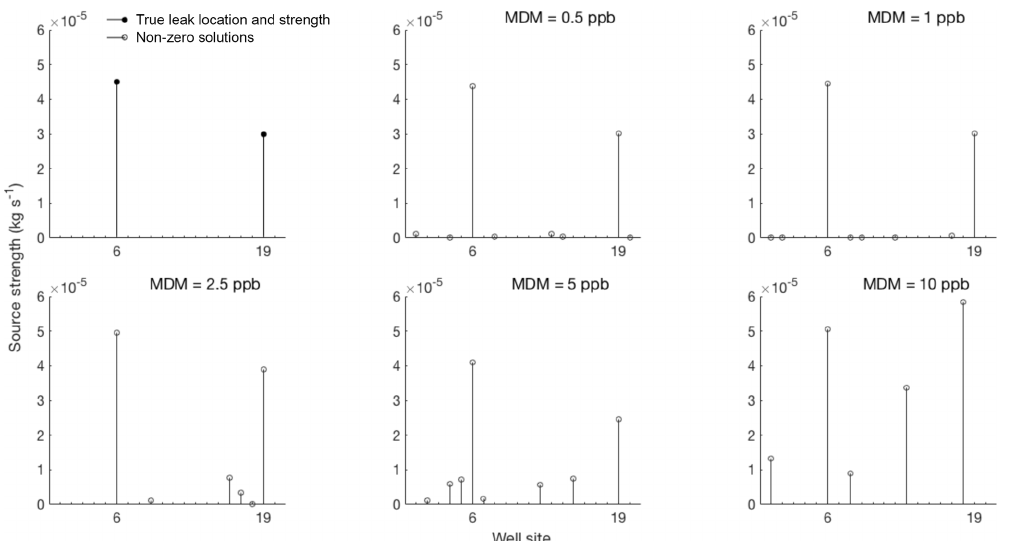
Figure 5. Top left panel shows well site numbers ( x axis) and corresponding “true” leak rates ( y axis), and remaining panels show resulting leak rate ( y axis) at each well site ( x axis) from non-bootstrap least squares fit to synthetic observations perturbed with model–data mismatch (MDM) noise shown, for the eight-beam case. Open circles show locations and strengths of all non-zero solutions.